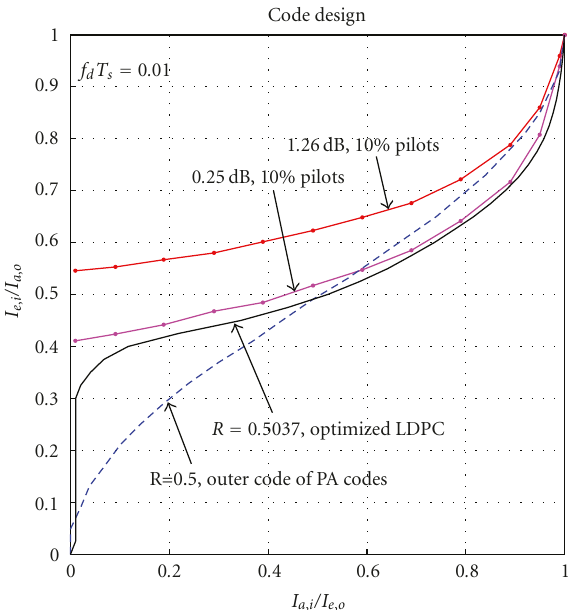
Figure 4: EXIT chart of a rate 0.5 LDPC ensemble optimized using convergence-evolution for di ff erential coding. Normalized Doppler rate is 0.01, 10% of pilot symbols are assumed to assist noncoherent di ff erential detection. Degree profile of the optimized LDPC ensemble: λ ( x ) = 0 . 0672 + 0 . 4599 x + 0 . 0264 x 8 + 0 . 0495 x 9 + 0 . 0720 x 10 +0 . 0828 x 11 +0 . 0855 x 12 +0 . 0807 x 13 +0 . 0760 x 14 , ρ ( x ) = x 5